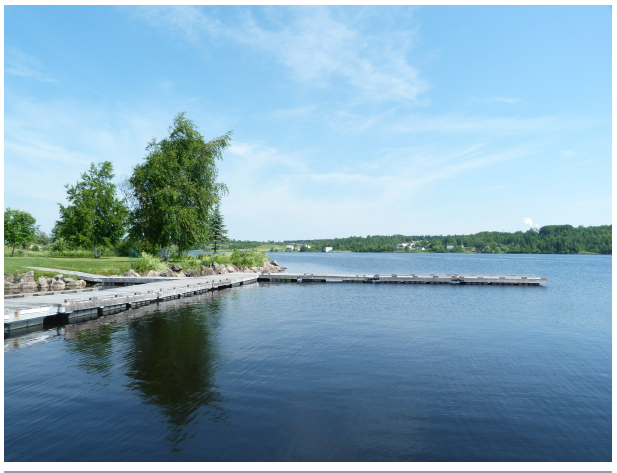
Fig. 3. Mactaquac headpond, viewed from the town of Nackawic. Photo: K.